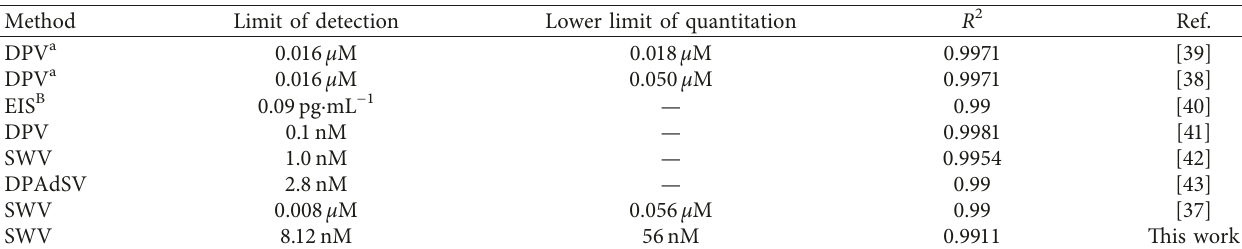
Table 3: Comparison of different methods for determination of